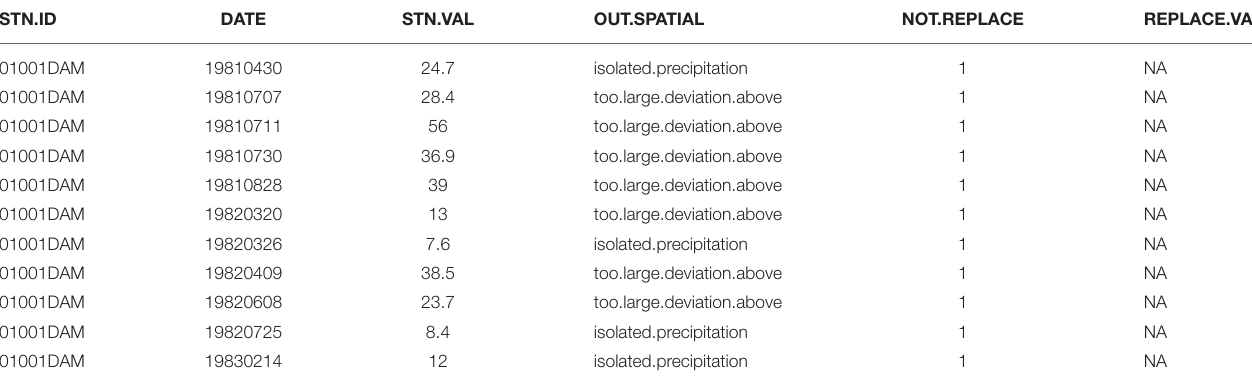
TABLE 1 | Example table of errors in CDT.